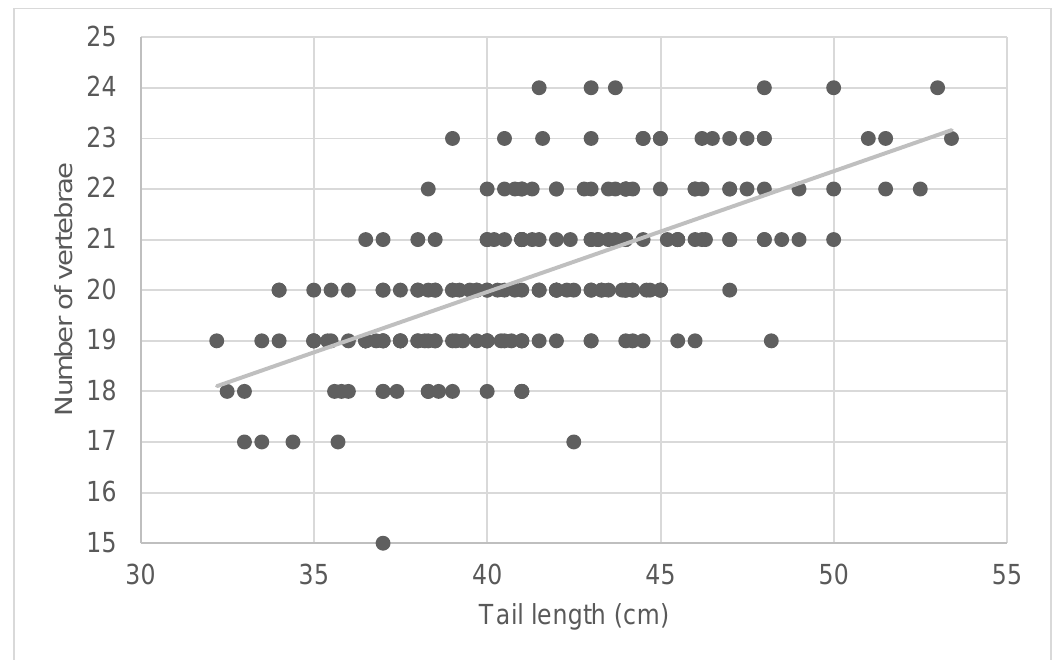
Figure 5. Symmetrical matrix representation for variables of tail length (cm) and number of vertebrae of lambs. The grey line represents the regression and was calculated as follows: y = 0.2387x + 10.419.